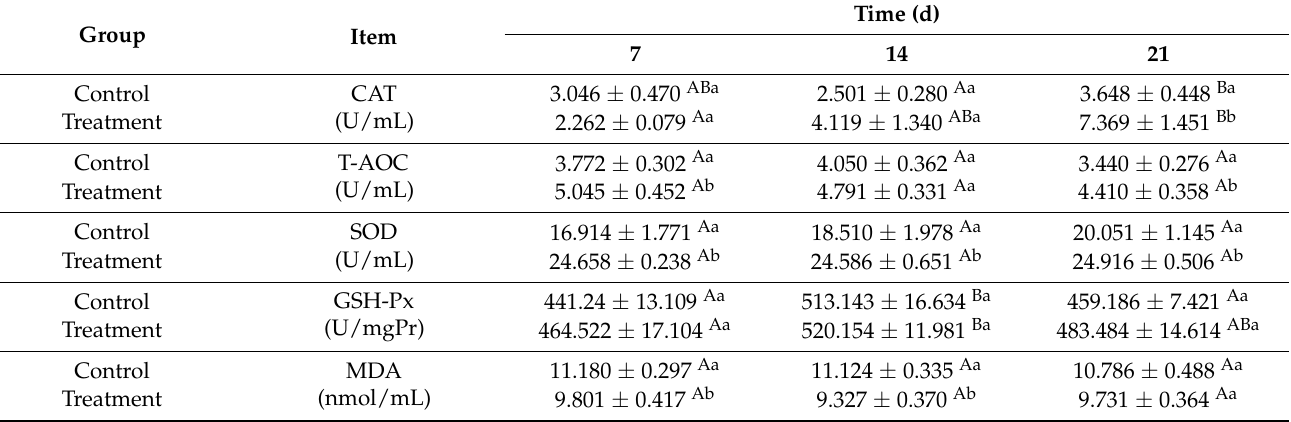
Table 7. The effects of experimental feed on antioxidant capacity in blood of newborn